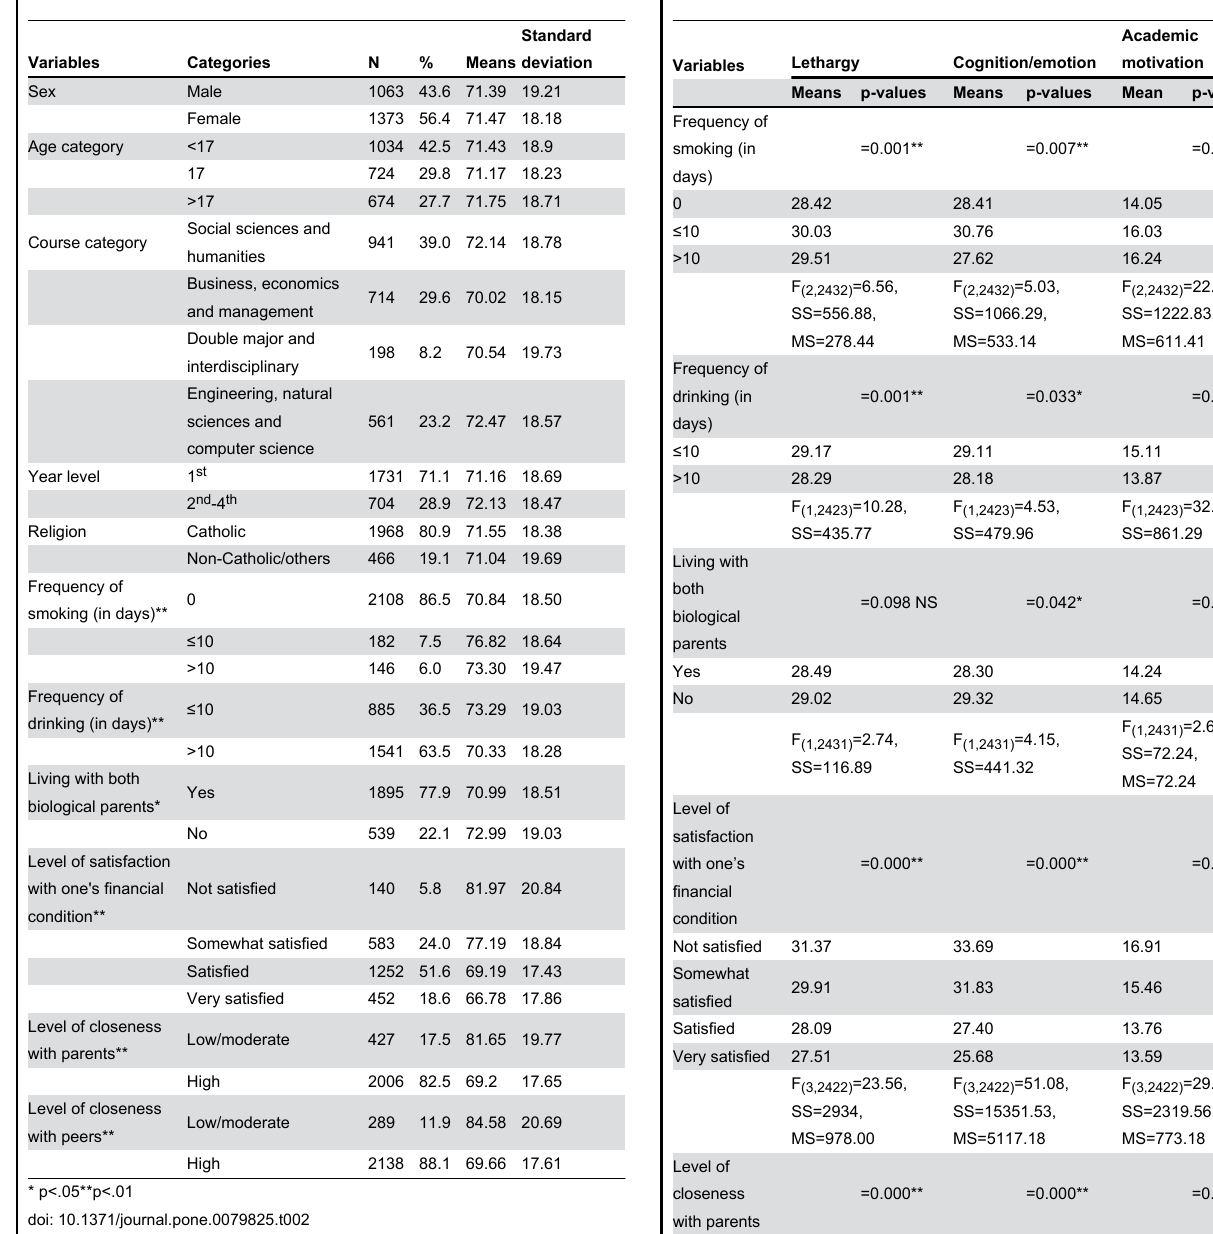
Differences in mean scale scores based on social and demographic characteristics The means and standard deviations for depressive symptoms scale scores are shown in Table 2. Higher means suggest higher or more severe levels of depressive symptoms. their symptoms levels. No significant differences were